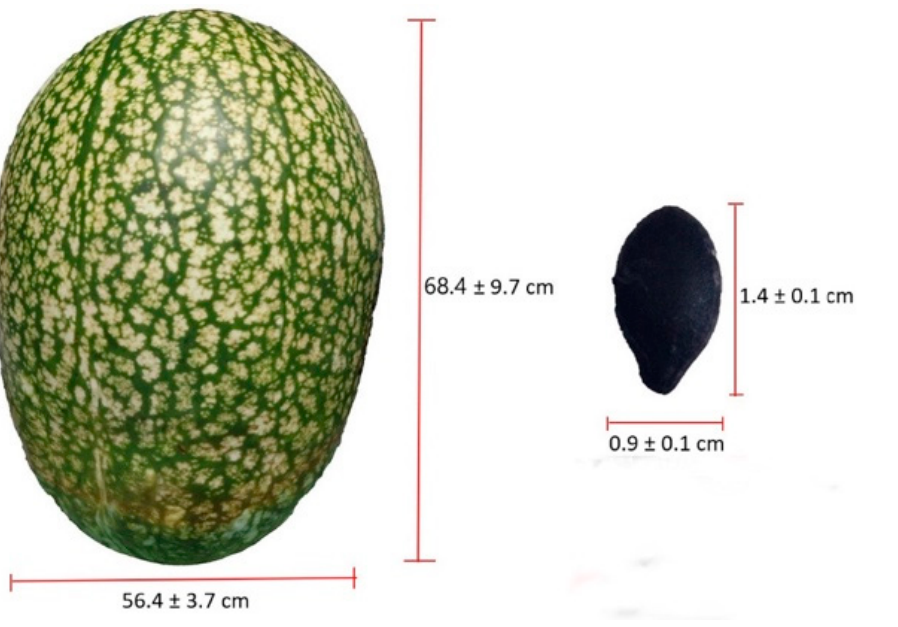
Figure 1. Sizes of the fruits and seeds of C. ficifolia . Table 1. Physical characteristics of C. ficifolia fruits and seeds (Mean ± S.D., n = 3).